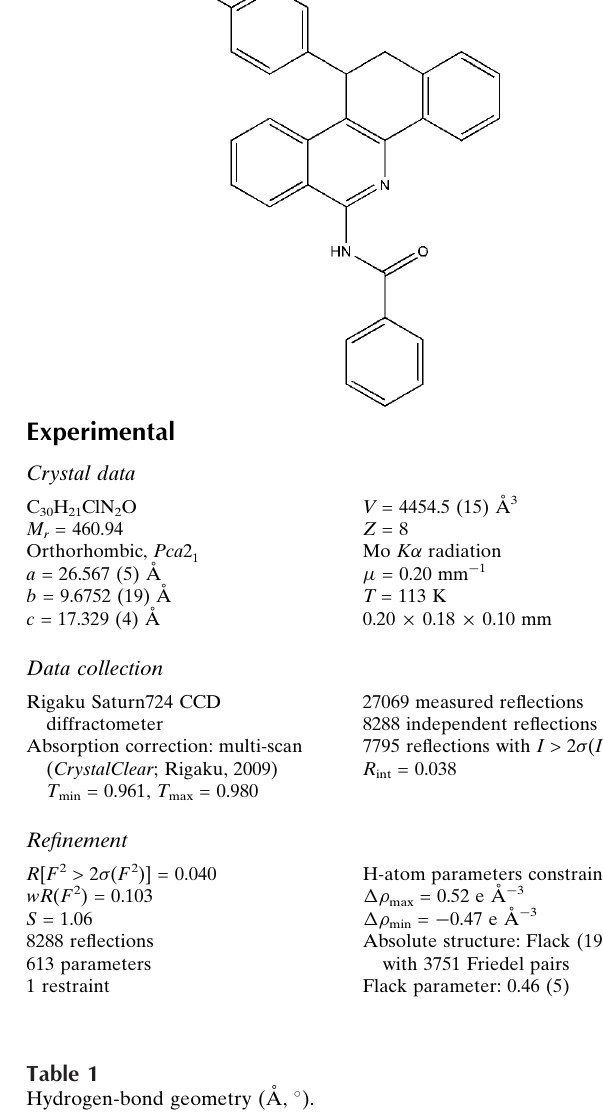
Hydrogen-bond geometry (A˚ , (cid:3)